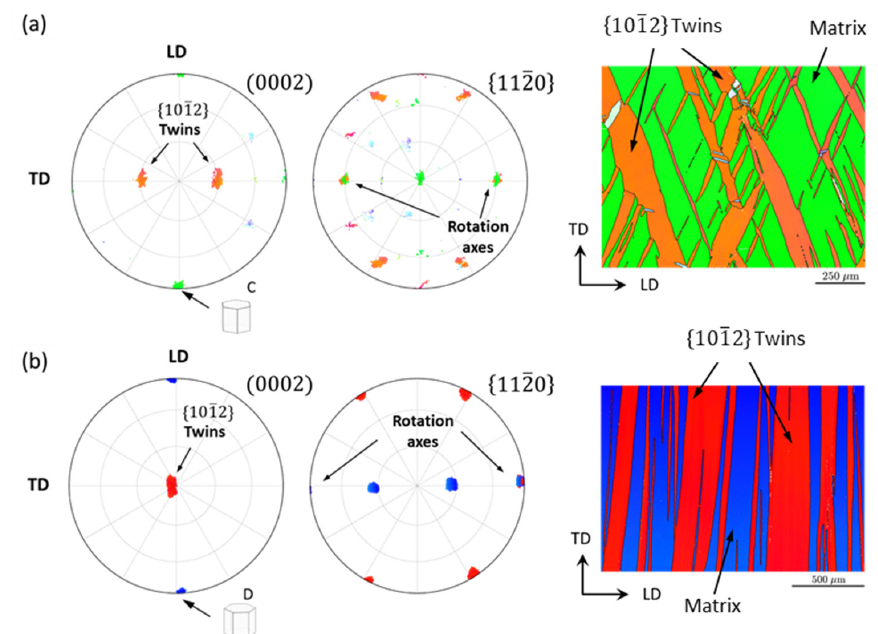
Figure 11. Discrete (scatter) pole figures and corresponding orientation maps for ( a ) orientation C and ( b ) orientation D at a true strain of − 3%.